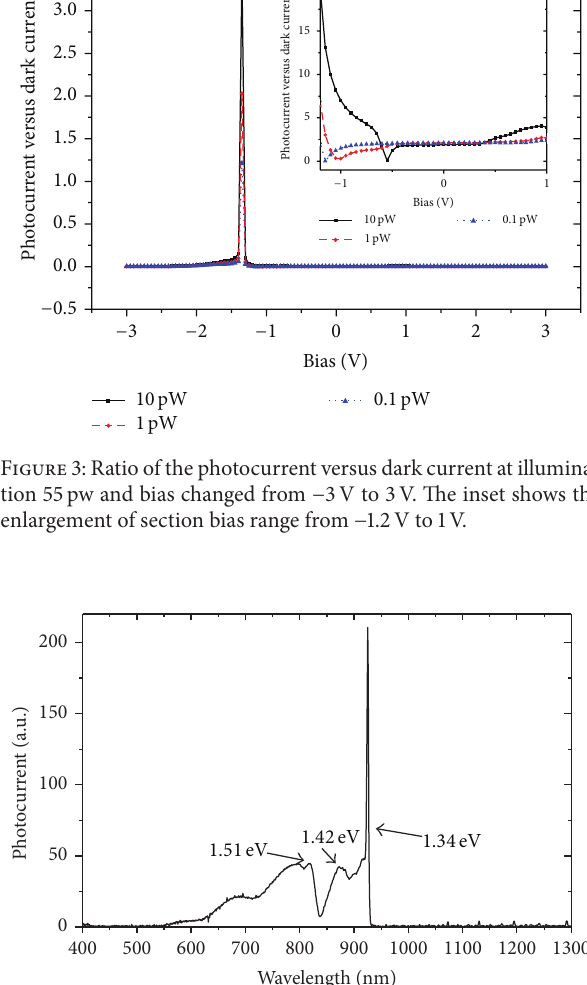
thus potentially provides even higher sensitivity. The result indicates that it is a promising detector for sensitive visible to near-infrared imaging